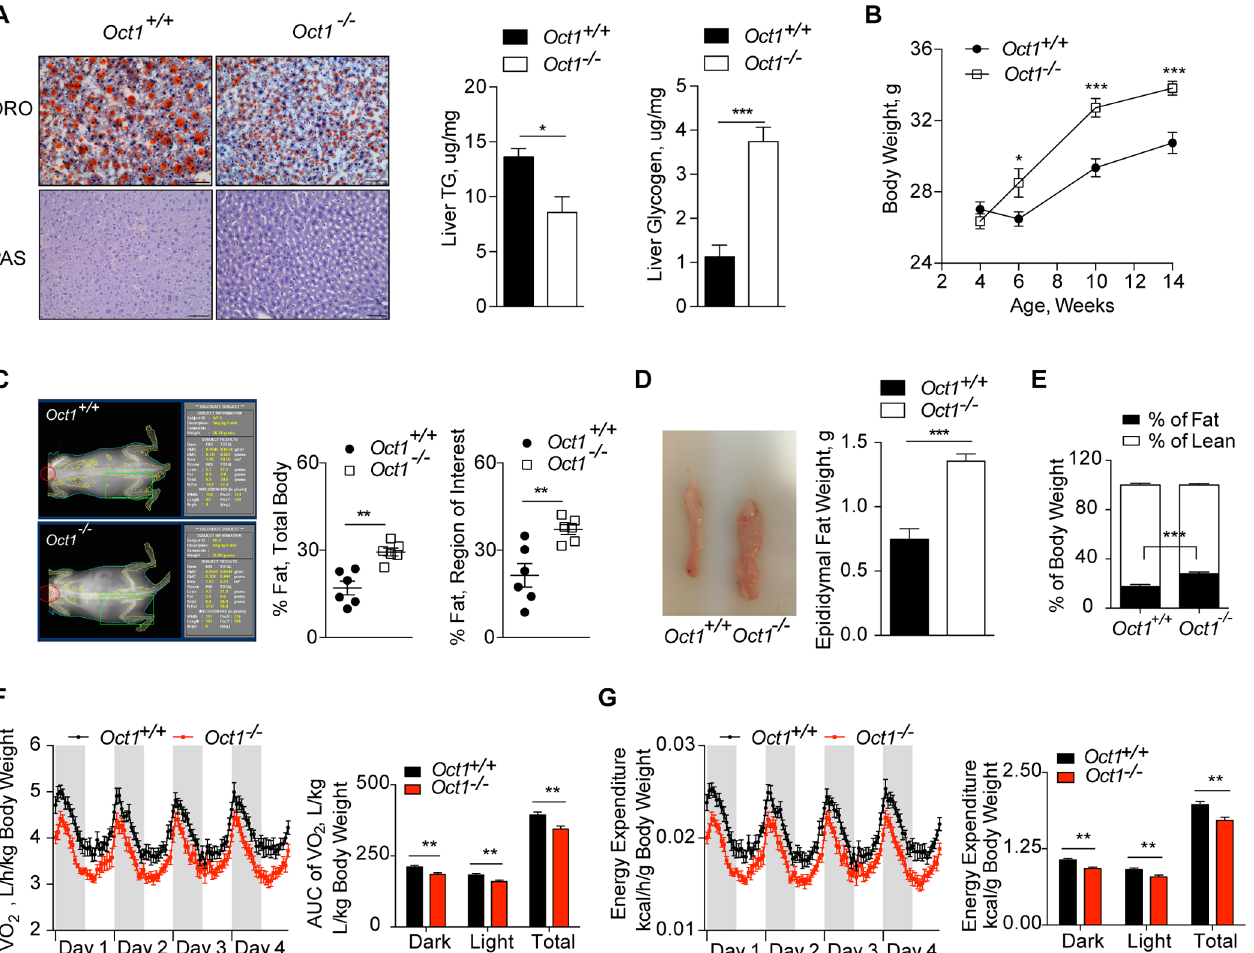
Fig 2. Oct1 deletion altered energy homeostasis in vivo. Beginning at 5 weeks, mice were treated with a thiamine control diet. (A) Representative images of ORO and PAS staining of mouse livers ( n = 3 per genotype); scale bars = 100 μ m. Quantified hepatic triglyceride ( n = 4 per genotype) and glycogen levels ( n = 10 per genotype) in mice fasted 16 hours overnight. (B) Body weight of mice from ages 4 to 14 weeks ( n = 12–24 per genotype at each time point). (C) Representative images for body composition measured by DEXA ( n = 6 per genotype). Percent of total body fat and percent of fat in the region is indicated by the green square ( n = 6 per genotype). (D) Representative images and weights of epididymal fat pads ( n = 14 per genotype). (E) Body composition of 12-week- old mice measured by EchoMRI before CLAMS ( n = 12 per genotype). (F) Respiratory O 2 consumption normalized by total body weight for 96 hours and calculated AUC ( n = 12 per genotype). (G) Energy expenditure normalized by total body weight for 96 hours and calculated AUC ( n = 12 per genotype). Data shown are mean ± SEM. Data were analyzed by unpaired two-tailed Student t test; (cid:3) p < 0.05, (cid:3)(cid:3) p < 0.01, and (cid:3)(cid:3)(cid:3) p < 0.001. Underlying data are provided in S1 Data. AUC, area under the curve; CLAMS, comprehensive laboratory animal monitoring system; DEXA, dual-energy X-ray absorptiometry; Oct1 ,organic cation transporter 1; ORO, Oil Red-O; O 2 , oxygen; PAS, Periodic-Acid Schiff’s; TG, triglyceride; VO 2 , oxygen consumption.